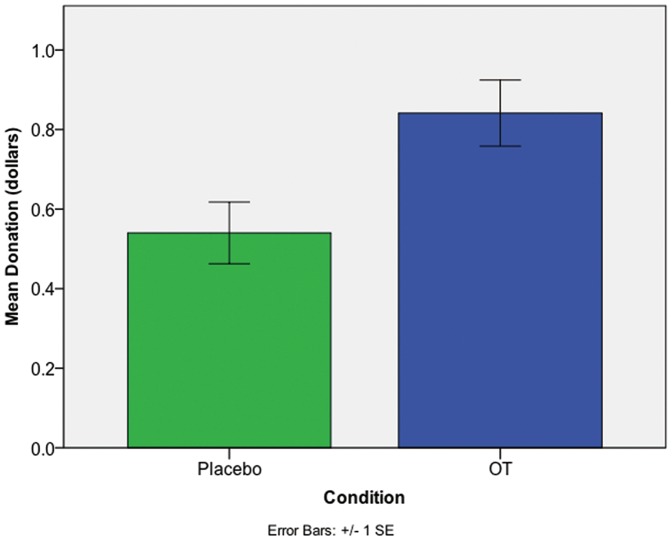
Average dollar donation by condition.Average donations among those who donated to ads +/- one standard error. Those who received OT donated on average 56% more after viewing ads than average donations by those who received a placebo (p = .001). This provides behavioral evidence that those on OT were more persuaded by the ads.